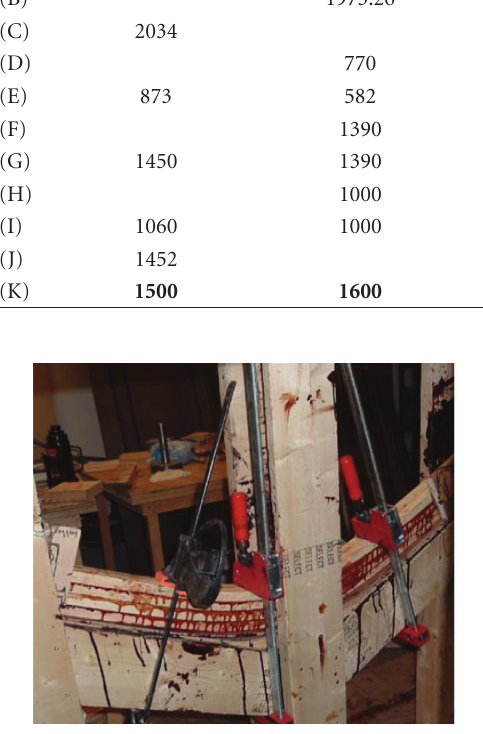
Figure 3: Special jig used for bending and gluing the glulam